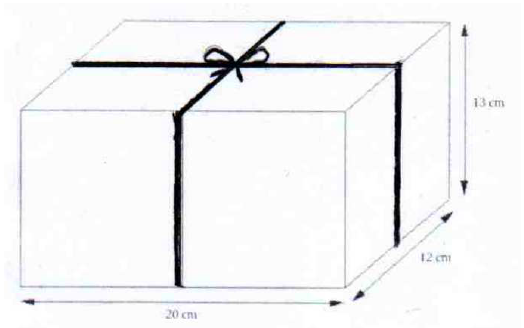
Fig. 2. Figure du